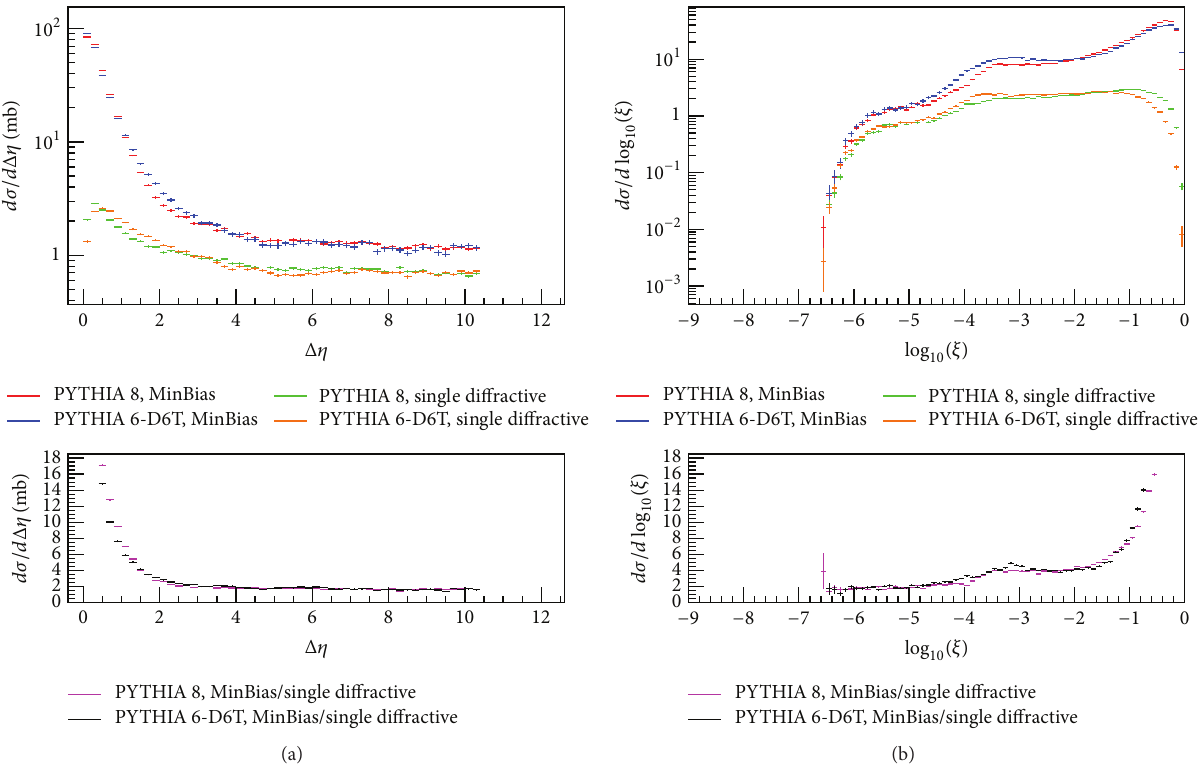
Figure 15: The distribution of 𝑑𝜎/𝑑Δ𝜂 (a) and 𝑑𝜎/𝑑 log 10 𝜉 (b) for different event classes simulated by PYTHIA 8 and PYTHIA 6-D6T. Only edge gaps are considered with a cut of 𝑝 T > 200 MeV for all final state particles in |𝜂| < 5.2